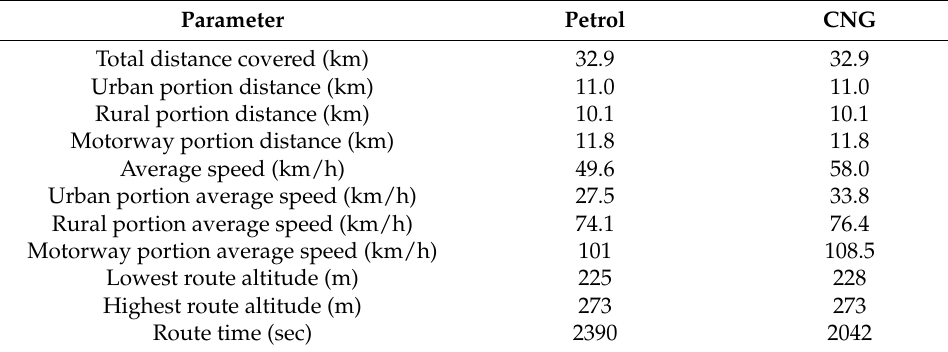
Table 4. Specifications of the on-road emission test.